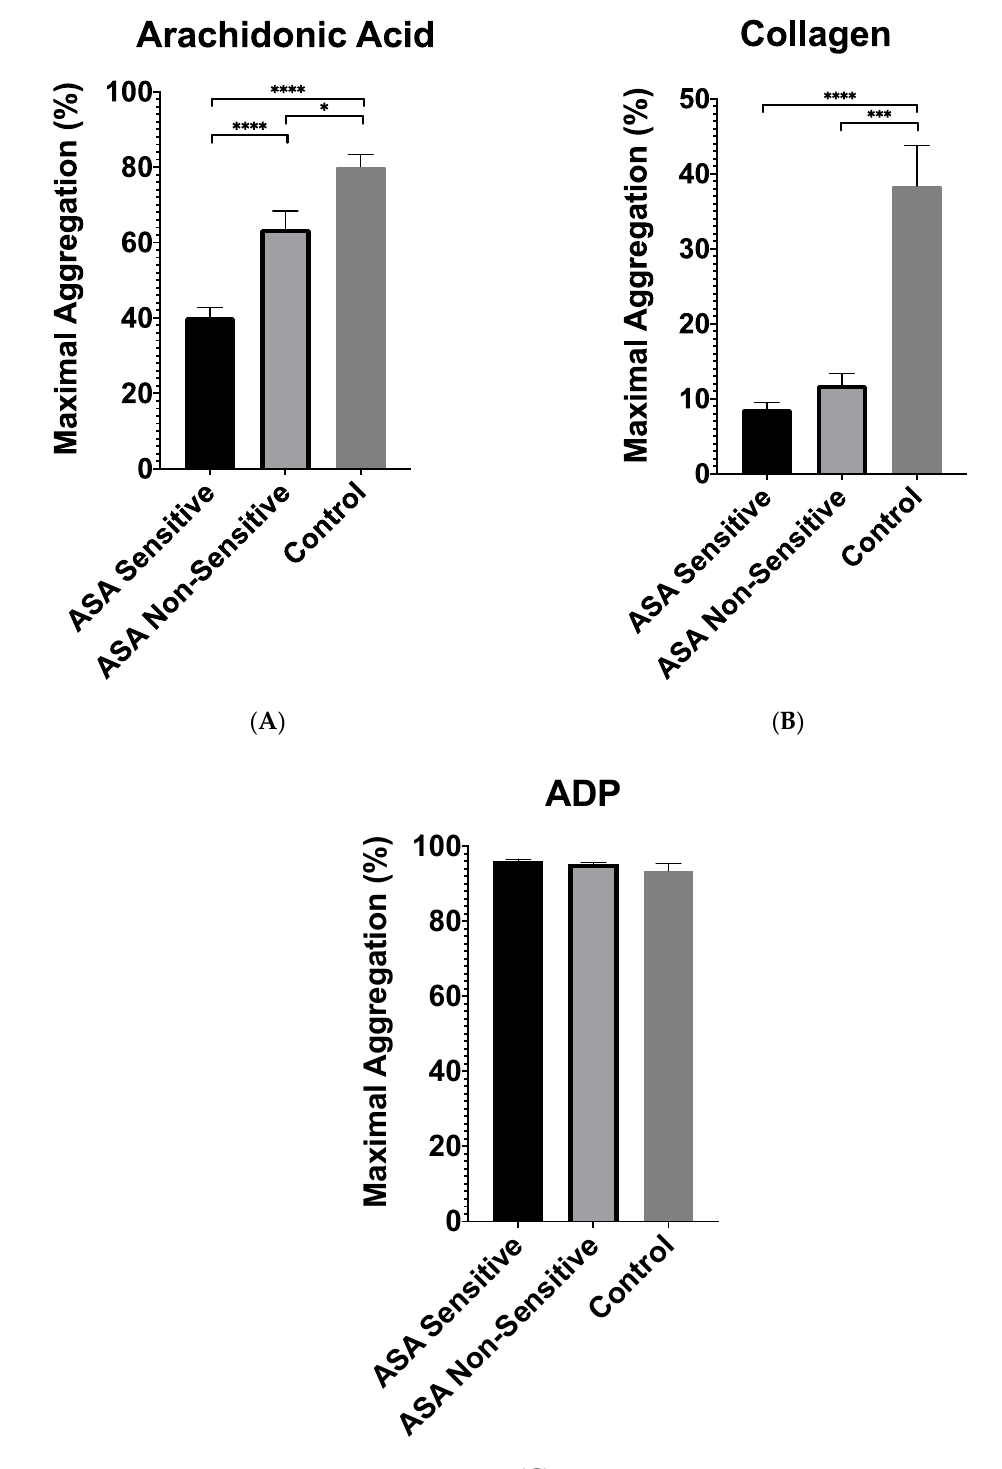
Figure 3. Plateletworks ® analysis between patients sensitive to 81 mg of ASA ( n = 30), and ASA non-sensitive ( n = 10) using platelet activation agonists ( A ) arachidonic acid, ( B ) collagen, and ( C ) adenosine 5’-diphosphate (ADP). Error bars represent standard error of the mean. Dotted line represents maximal aggregation in control patients not taking 81 mg of ASA. * represents p < 0.05; *** represents p < 0.001; and **** represents p < 0.0001.